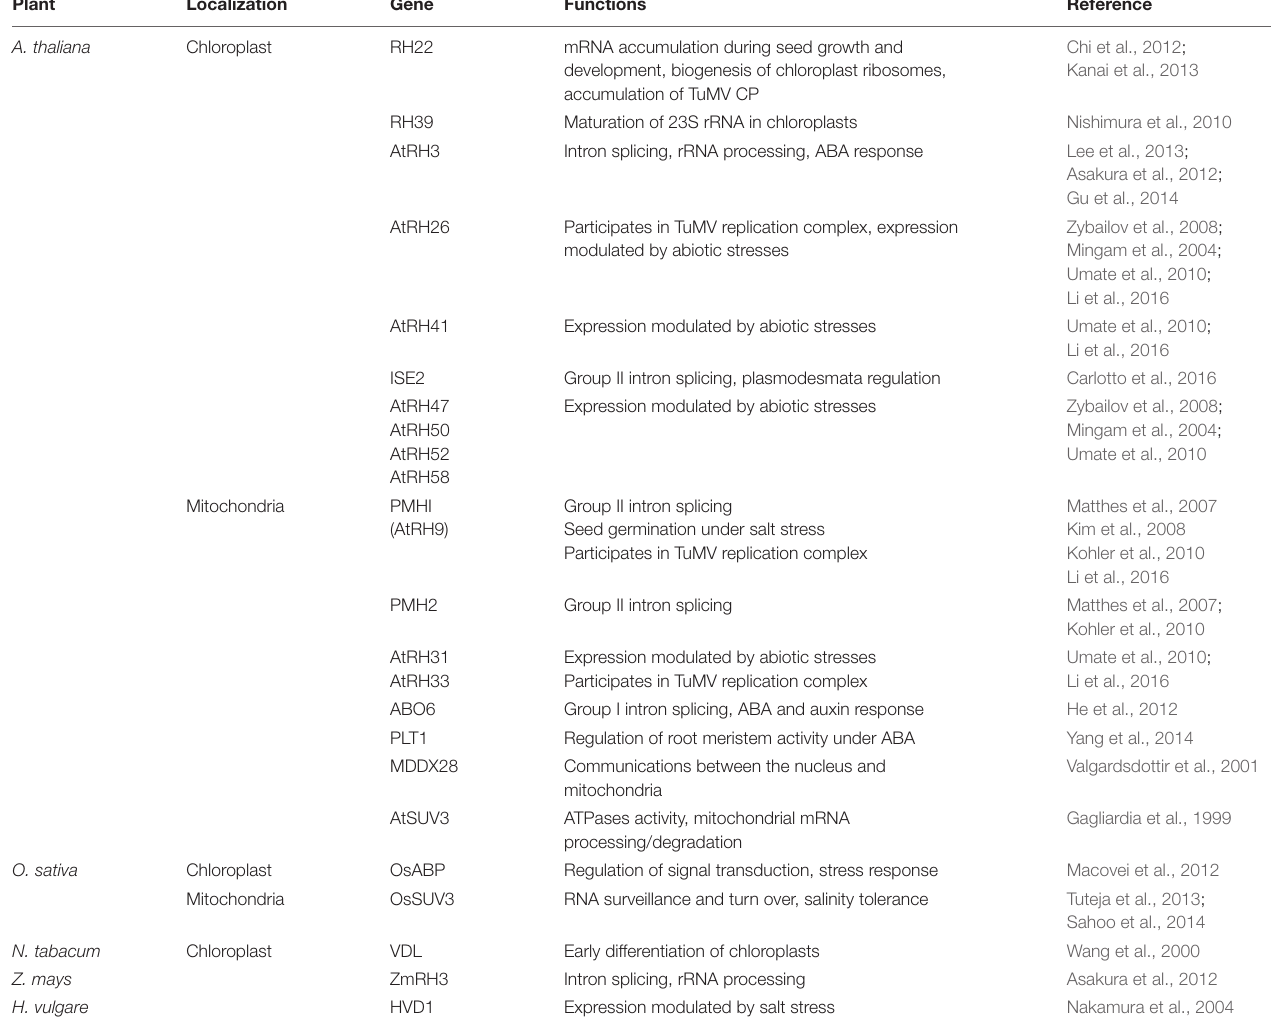
TABLE 1 | List of DEAD-box RHs associated with RNA metabolism in chloroplasts or mitochondria and stress responses in various